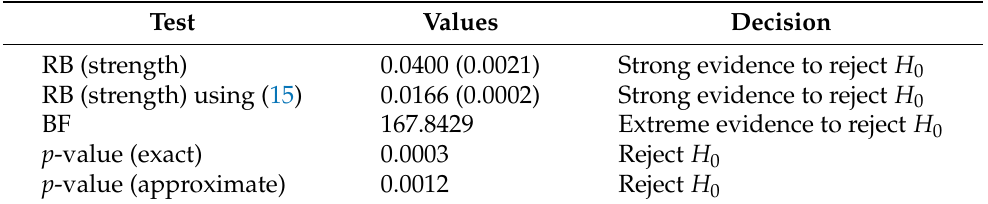
Table 1. Test results of Example